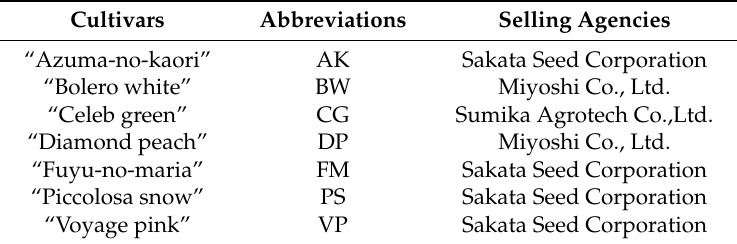
Table 1. Lisianthus cultivars used in the present